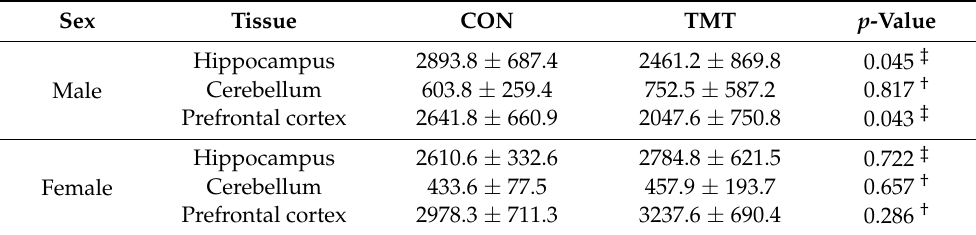
Table 2. Prenatal TMT exposure alters male mitochondrial DNA copy numbers.